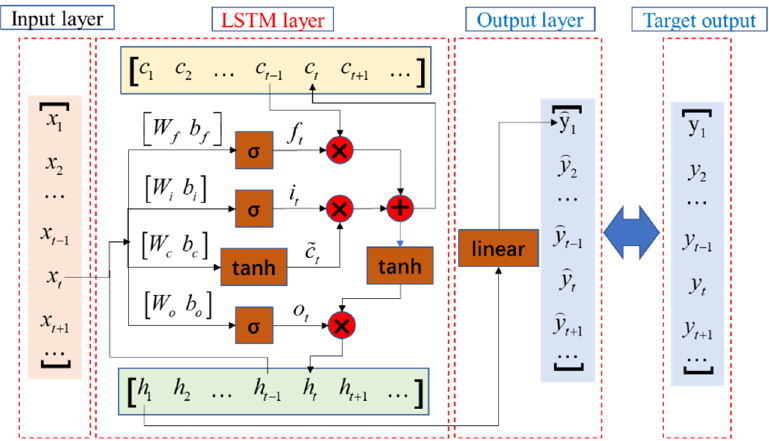
Figure 2. The architecture of long short ‐ term memory (LSTM) network.